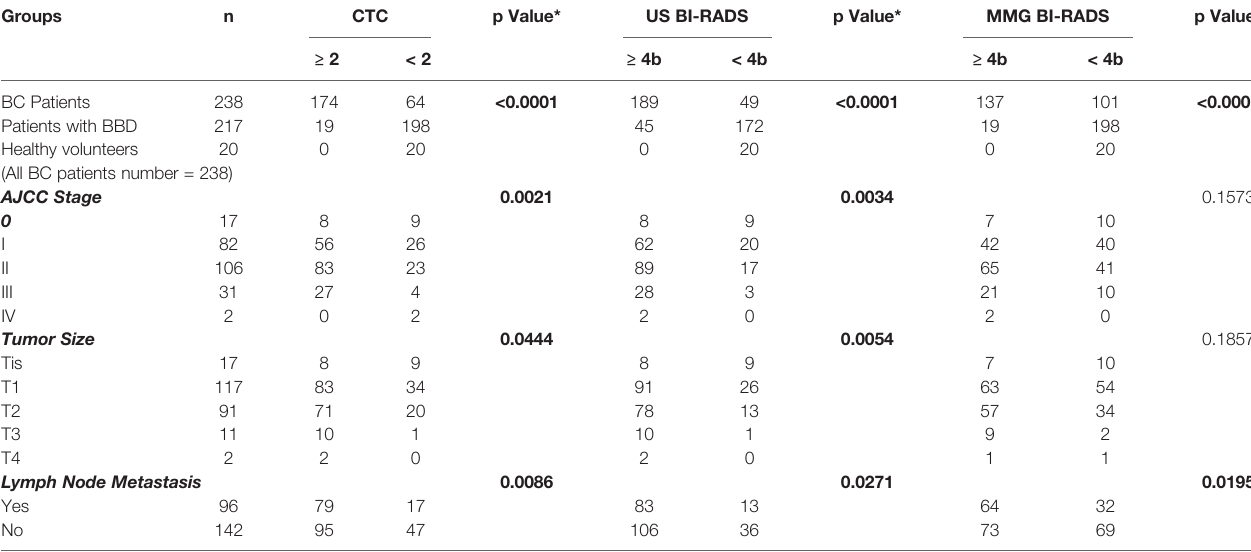
TABLE 3 | Clinicopathological characteristics of BC patients with ≥ 2 or < 2 CTC, with US BI-RADS score ≥ 4b or < 4b, and with MMG BI-RADS score ≥ 4b or < 4b.